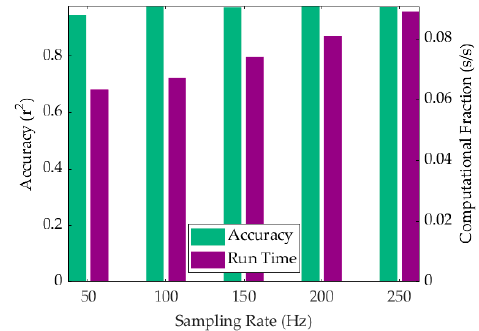
Figure 8. Algorithm efficiency shown as a combination of computational time per second of real-time data analyzed (purple) and the corresponding r 2 accuracy (green). data analyzed (purple) and the corresponding r 2 accuracy